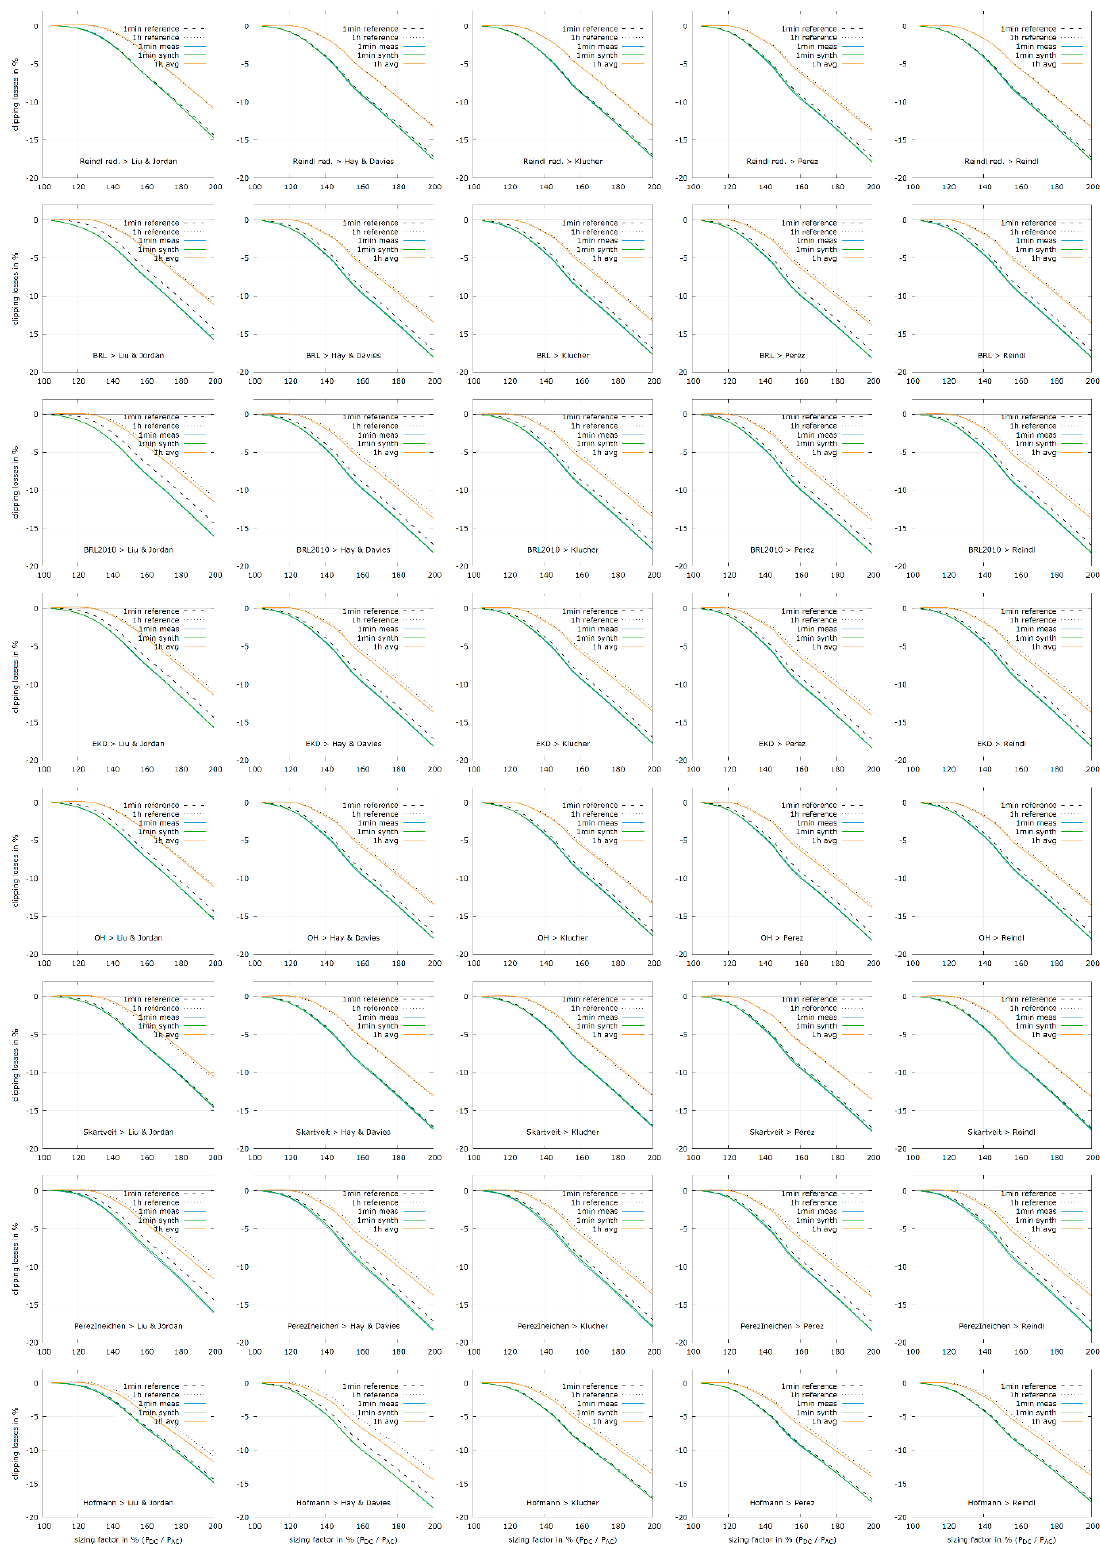
Figure A5. Inverter clipping losses as a function of the sizing factor of the PV plant, for one-minute measurement and synthesized data and one-hour averages. Rows refer to different diffuse fraction models, whereas columns refer to the five transposition models.